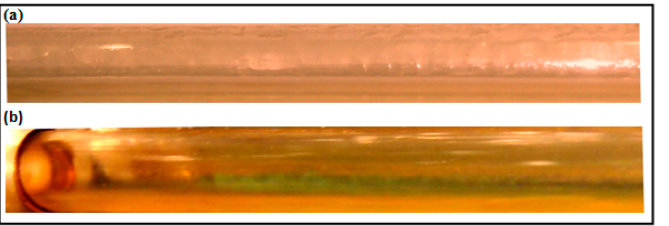
Figure 7. ( a ) Annular flow regime without DRP (V sl =0.1 m/s, V sg = 9.05 m/s); ( b ) Annular flow regime with 40 ppm of DRP.